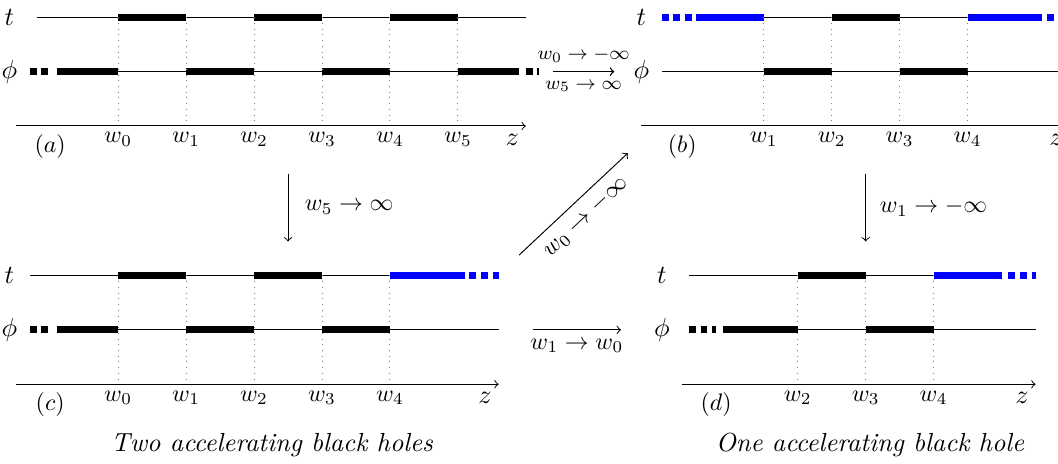
Figure 10 . ( a ) Rod diagram for a collinear three-black hole system (an Israel-Khan solution). The limit w 0 and w 5 gives ( b ) the single black hole in the expanding bubble. When sending → −∞ → ∞ w a ) we obtain ( c ) two accelerating black holes. Collapsing one timelike rod in the latter 5 → ∞ in ( gives ( d ) the C-metric for a single accelerating black hole. The rod limits commute, so from the two accelerating black holes in ( c ) , the limit w 0 gives ( b ) a single black hole in a → −∞